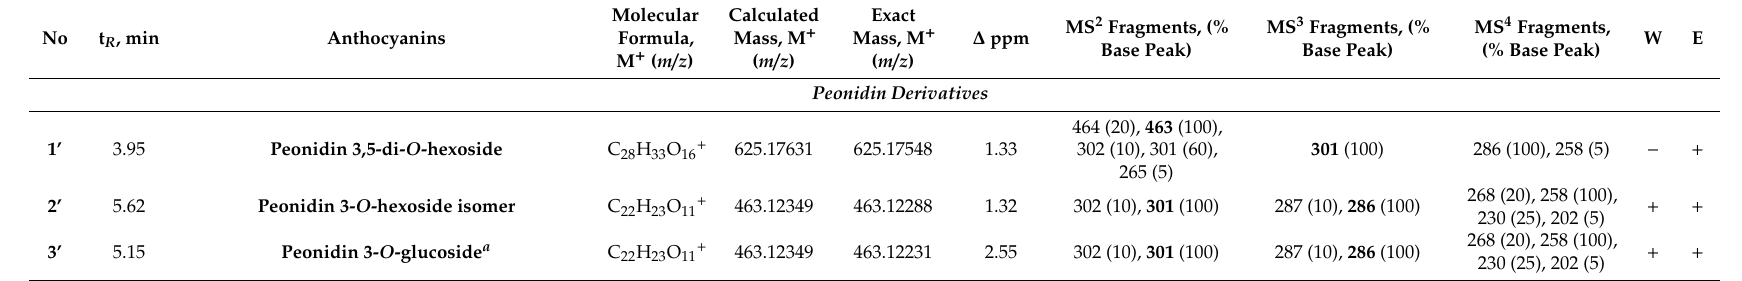
Table 3. High resolution mass spectrometry (MS) data and positive ion MS 2 , MS 3 , and MS 4 fragmentation of anthocyanins identified in Vranac wine (W) and berry skin (E)